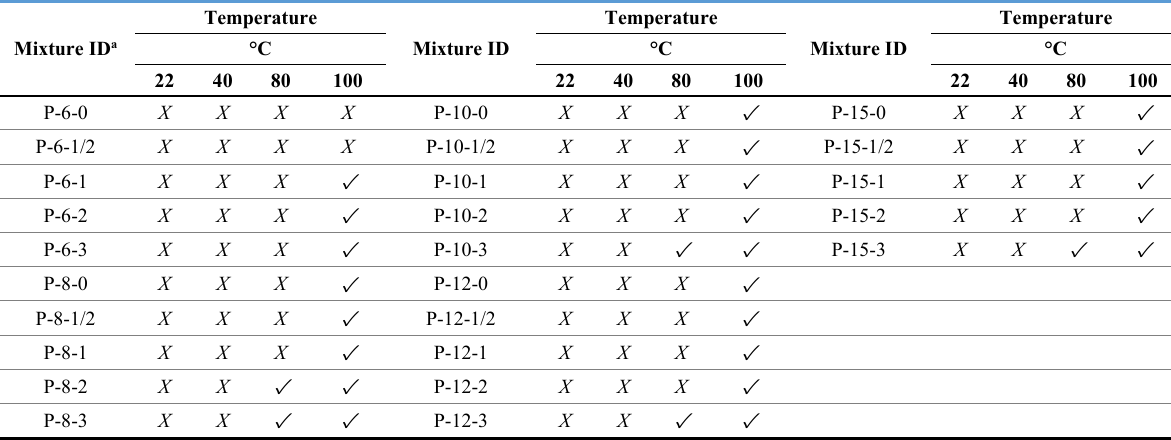
Table 3. Hard-mini-test (HMT) results at 7 days of